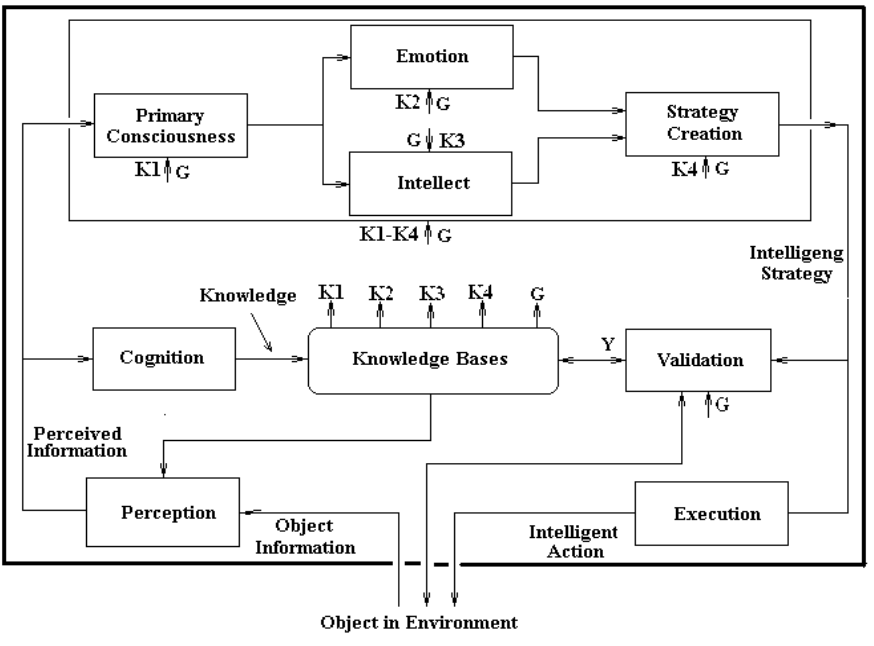
Figure 5. A detailed model for processes in information studies.